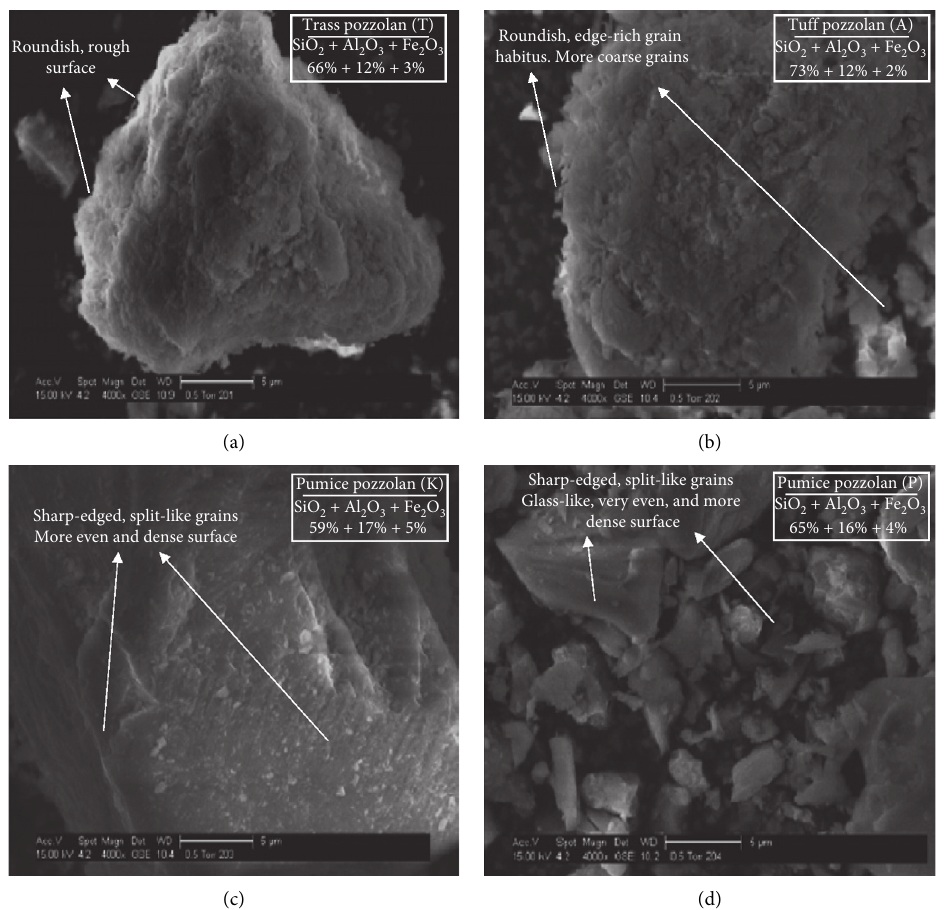
Figure 10: Environmental scanning electron microscope (ESEM) images of various types of pozzolans providing an insight to particulate characteristics (reproduced from research study by [121] with some